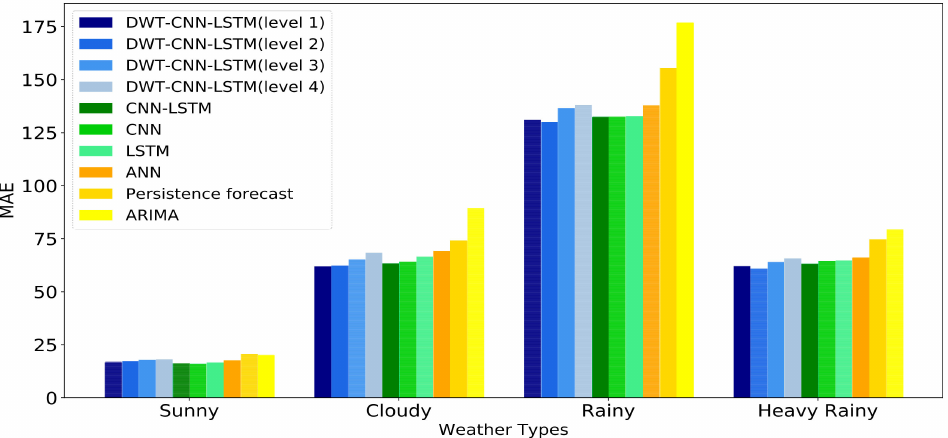
Figure 13. The MAE of different forecasting models for sunny, cloudy, rainy and heavy rainy days using the dataset of Desert Rock